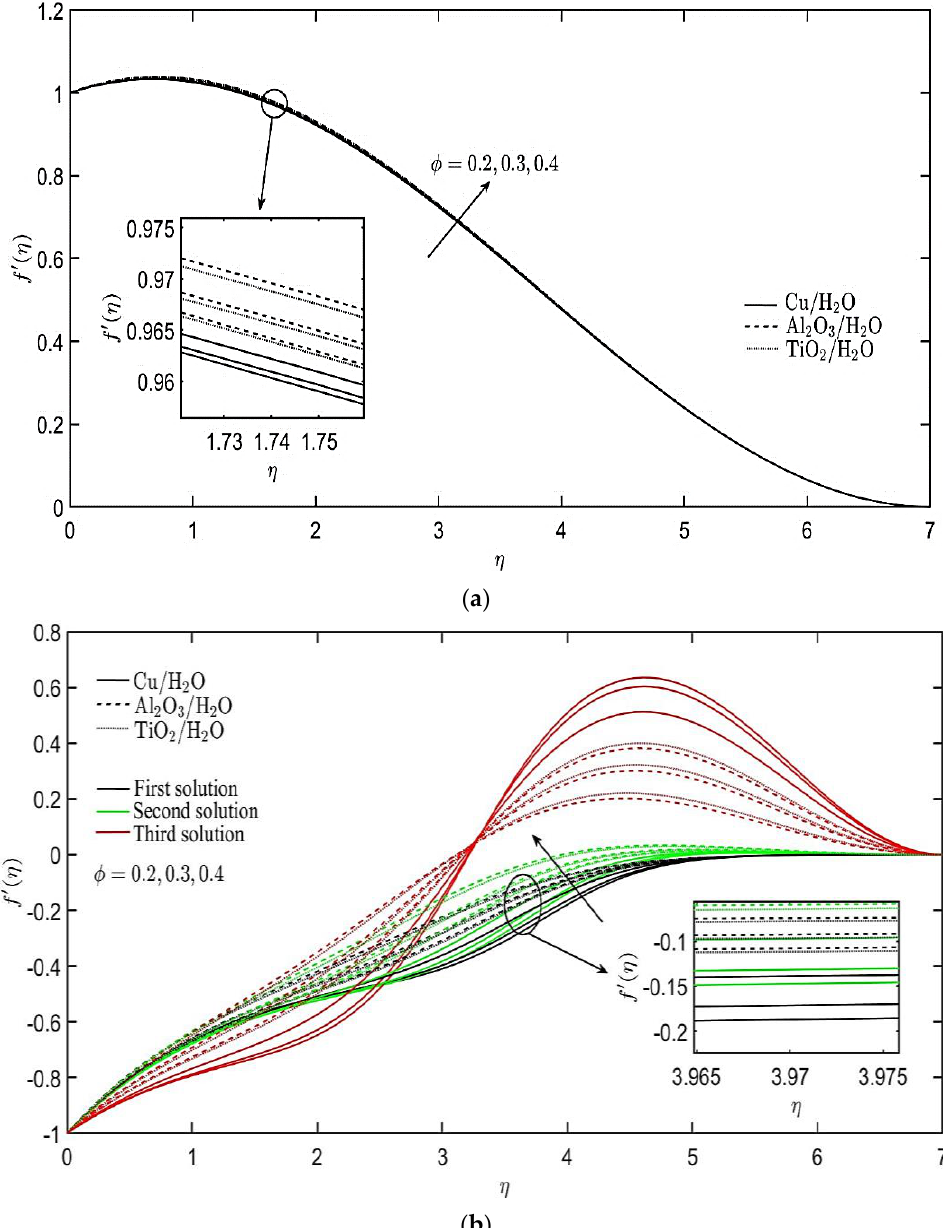
Figure 4. Effect of nanoparticle volume fraction on velocity profiles for: ( a ) Stretching case; ( b ) Shrinking case.